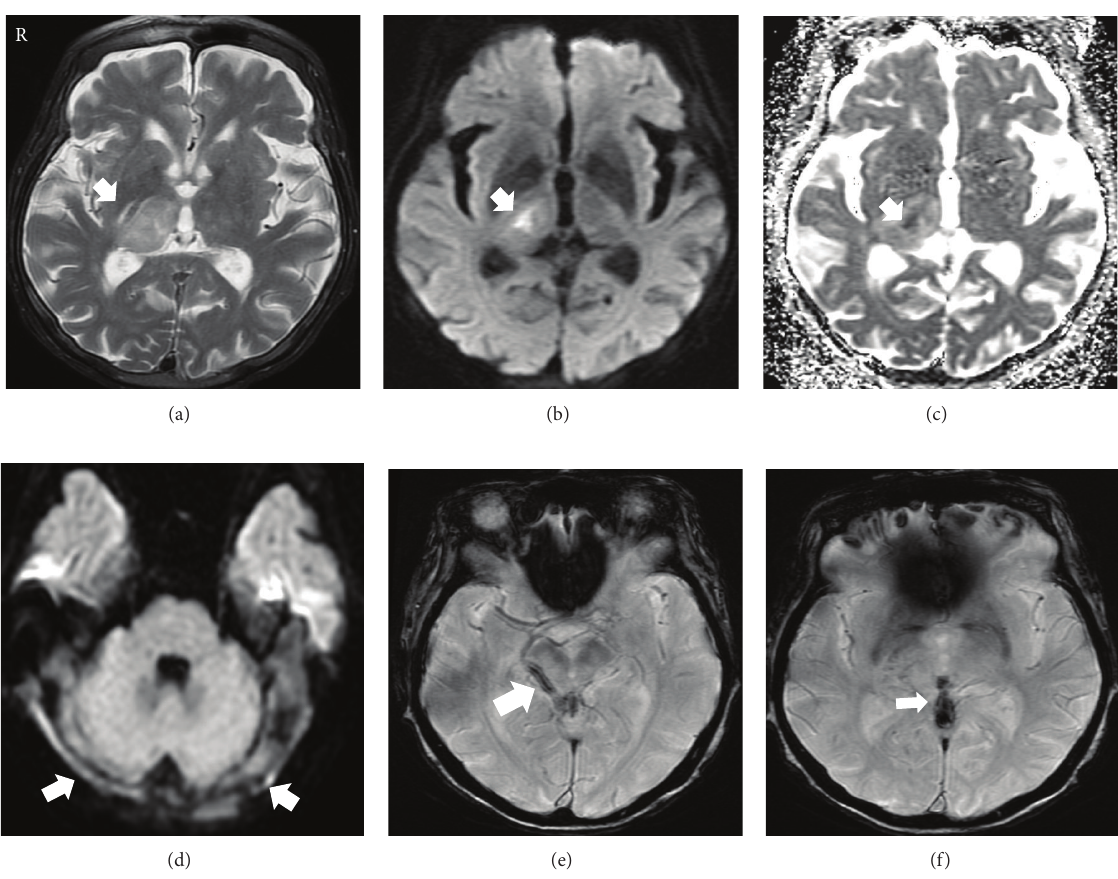
Figure 1: On admission, T2-weighted images (T2WIs) showed a diffuse high-intensity lesion in the right thalamus, extending into the posterior limb of the internal capsule and midbrain (a). The central part of the right thalamic lesion showed high intensity on the diffusion- weighted image, (b) and a decreased apparent diffusion coefficient (c). Both transverse sinuses showed high intensity on the diffusion- weighted image (d). T2 ∗ WI showed diminished signal and enlargement of the right basilar vein (e) and the vein of Galen (f).